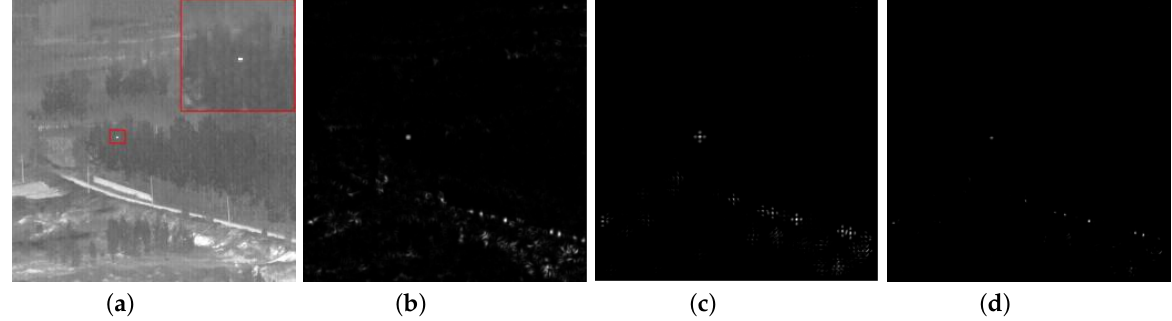
Figure 4. The local a priori extraction method proposed by the algorithm in this paper. ( a ) Infrared image containing dim and small targets; ( b ) weighted image describing corner point information; ( c ) weighted image describing background information; ( d ) final weighted image